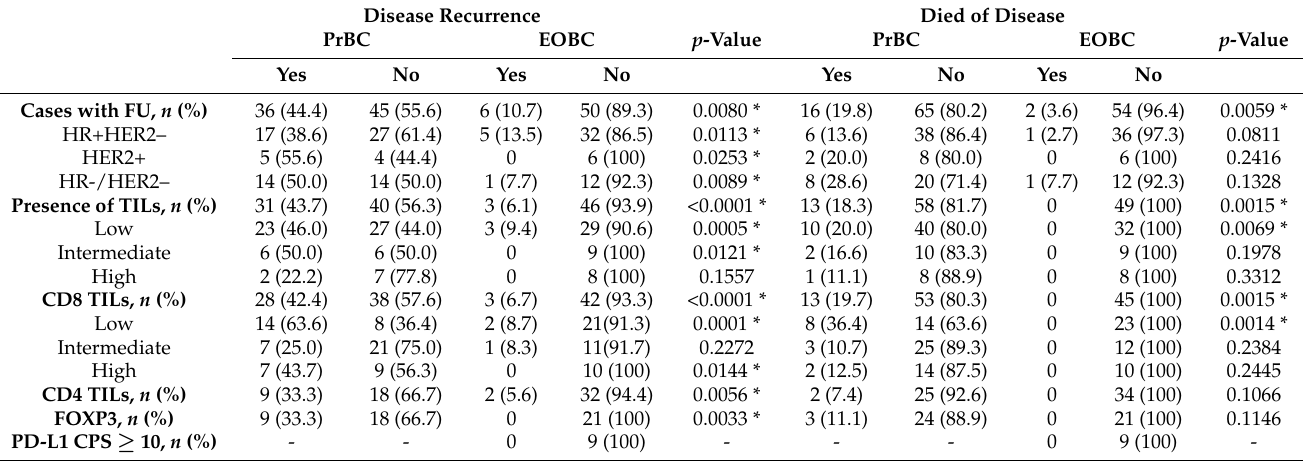
Table 3. Disease progression and patients’ death status in the study and control groups. PrBC, breast cancer during pregnancy; EOBC, early-onset breast cancers; HR, hormone receptors; TILs, tumor-infiltrating lymphocytes; FOXP3, forkhead box P3; PD-L1, programmed death-ligand 1; CPS, combined positive score. Significant correlations are highlighted with a star